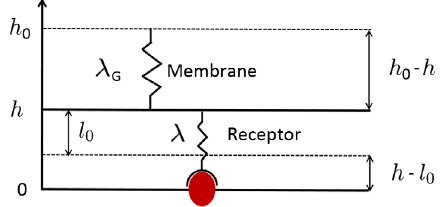
FIG. 5. Spring model of the interaction between a ligand and a receptor confined to a Gaussian membrane. The membrane is represented by a harmonic spring, with the rest position at h 0 . The receptor is represented by a harmonic spring of stiffness λ and rest length l 0 , which is coupled in series with the membrane spring. The ligand is represented by the red